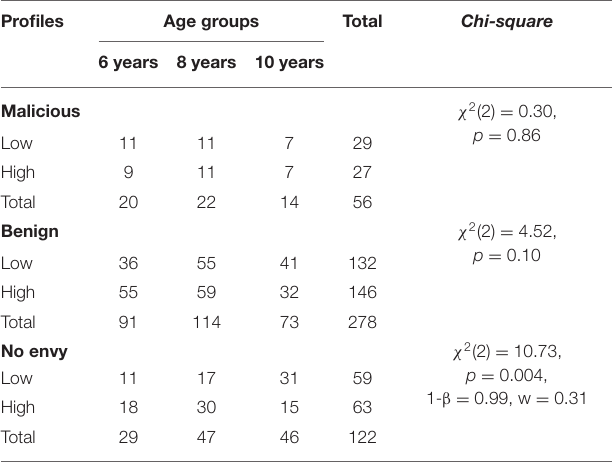
TABLE 4 | Frequency distribution of verbal profiles of responses by age group.